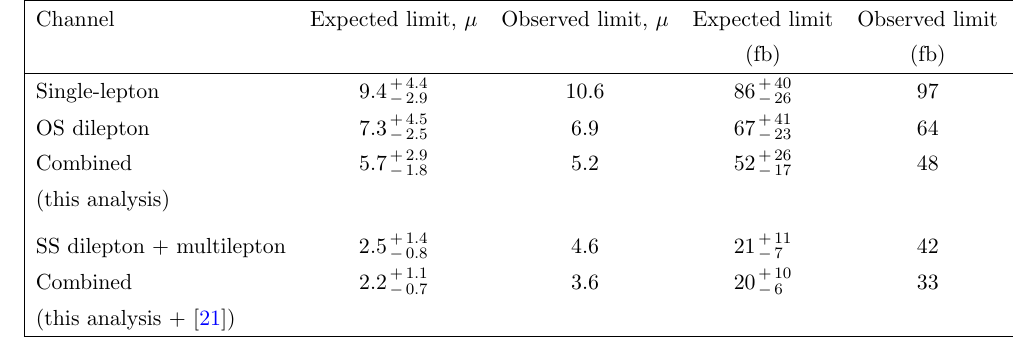
Table 3 . Expected and observed 95% CL upper limits on SM tttt production as a multiple of (cid:27) SM and in fb. The results for the two analyses from this paper are shown separately and combined. The results from a previous CMS multilepton search are also given [21]. The values quoted for the uncertainties in the expected limits indicate the regions containing 68% of the distribution of limits expected under the background-only hypothesis. The expected upper limits are calculated assuming that the data are distributed according to the prediction of the background-only model corresponding to the scenario with signal strength modi(cid:12)er value (cid:22) =